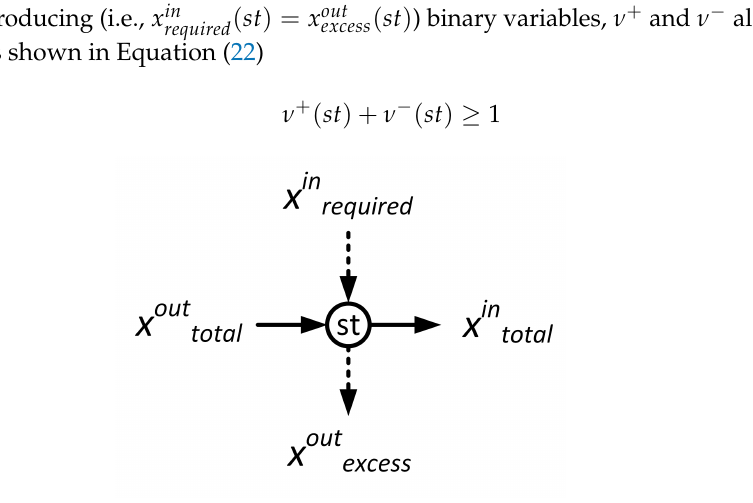
( st ) indicates all st produced by the total ( st ) indicates the amount required